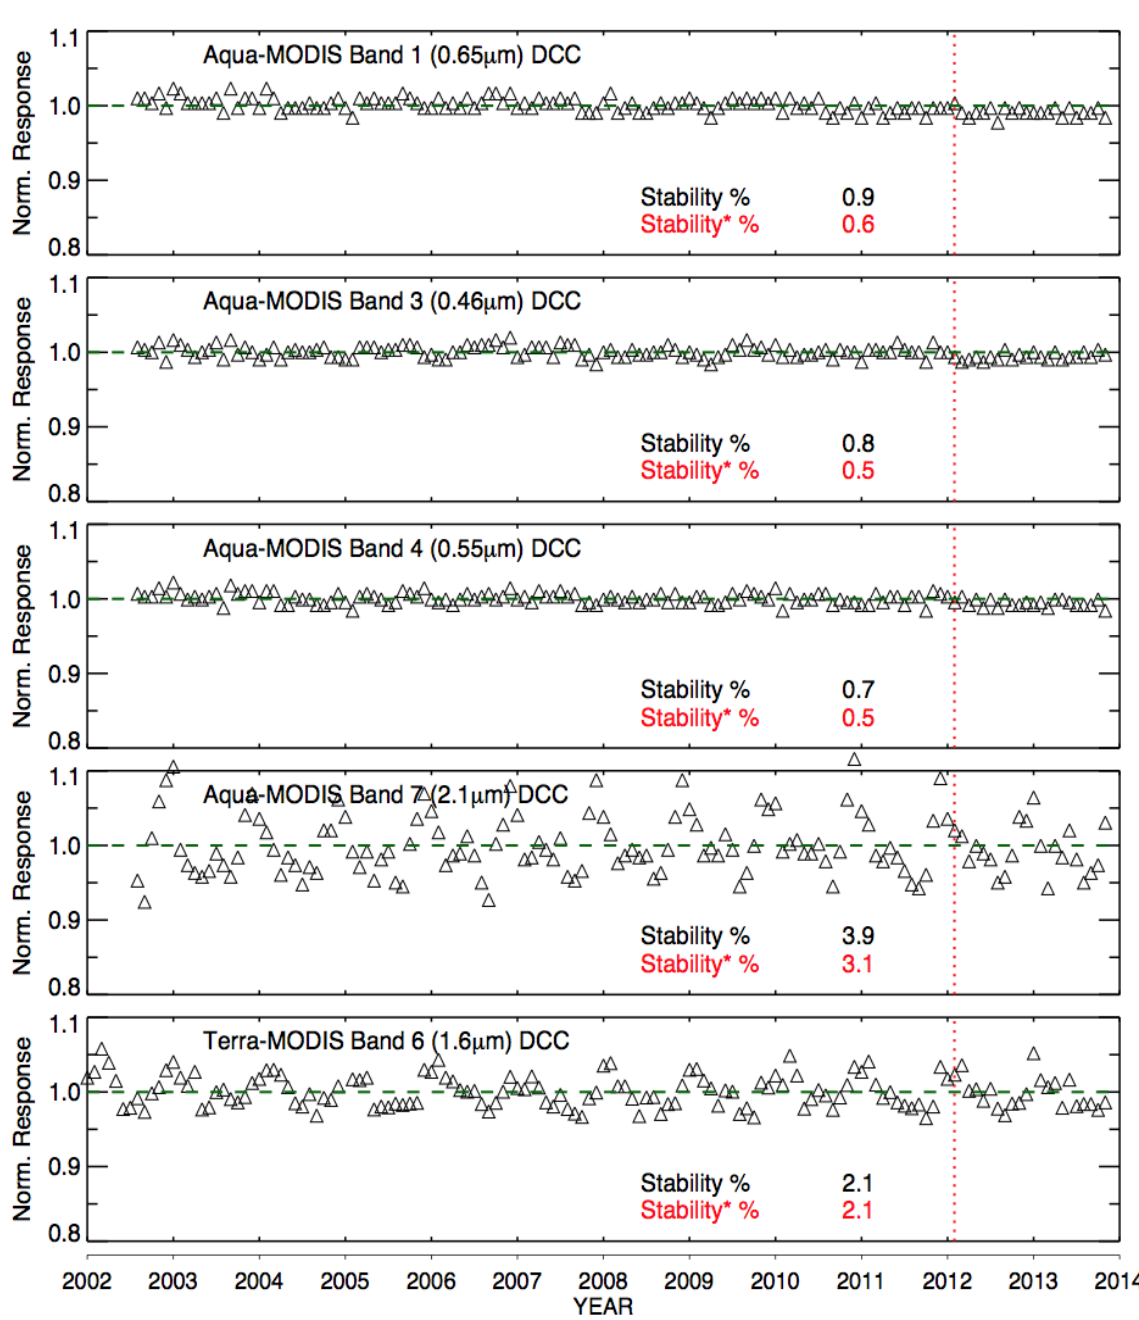
Figure 6. Same as Figure 5, except for the DCC invariant target. The MODIS band 2 saturates for DCC